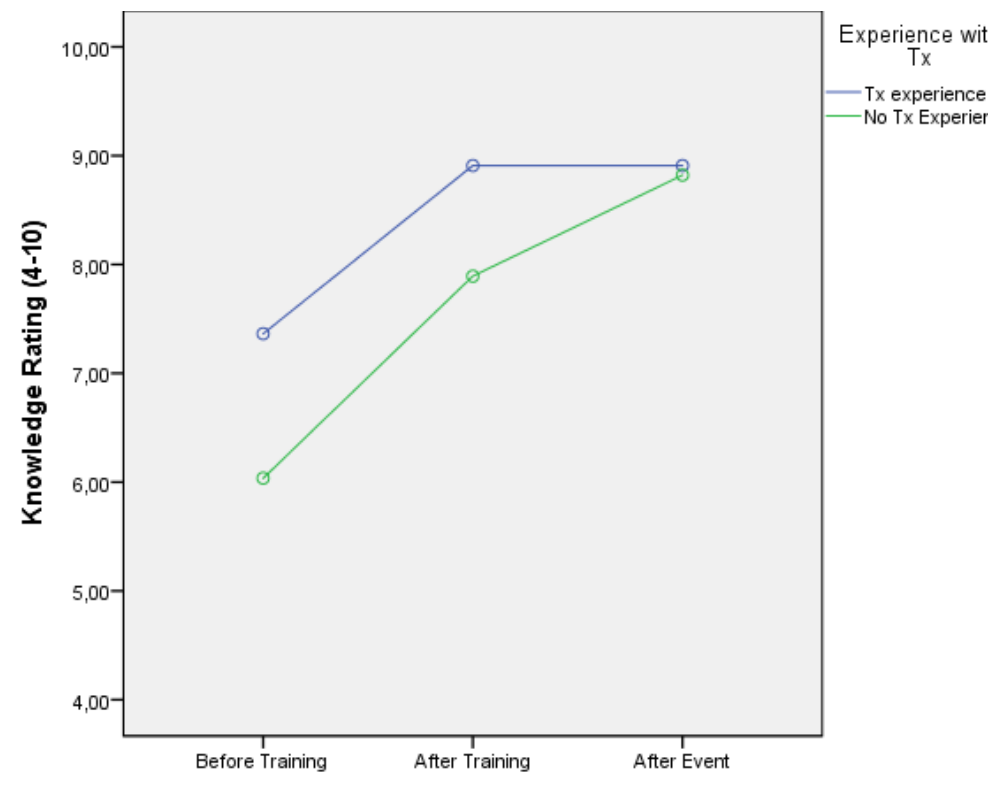
Figure 2. Changes in knowledge rating (mean scores) by groups Metsäranta, 2006) and Gymnastics (Laitila, Ratilainen, Puronaho, & Virkkunen, 2015), the episodic